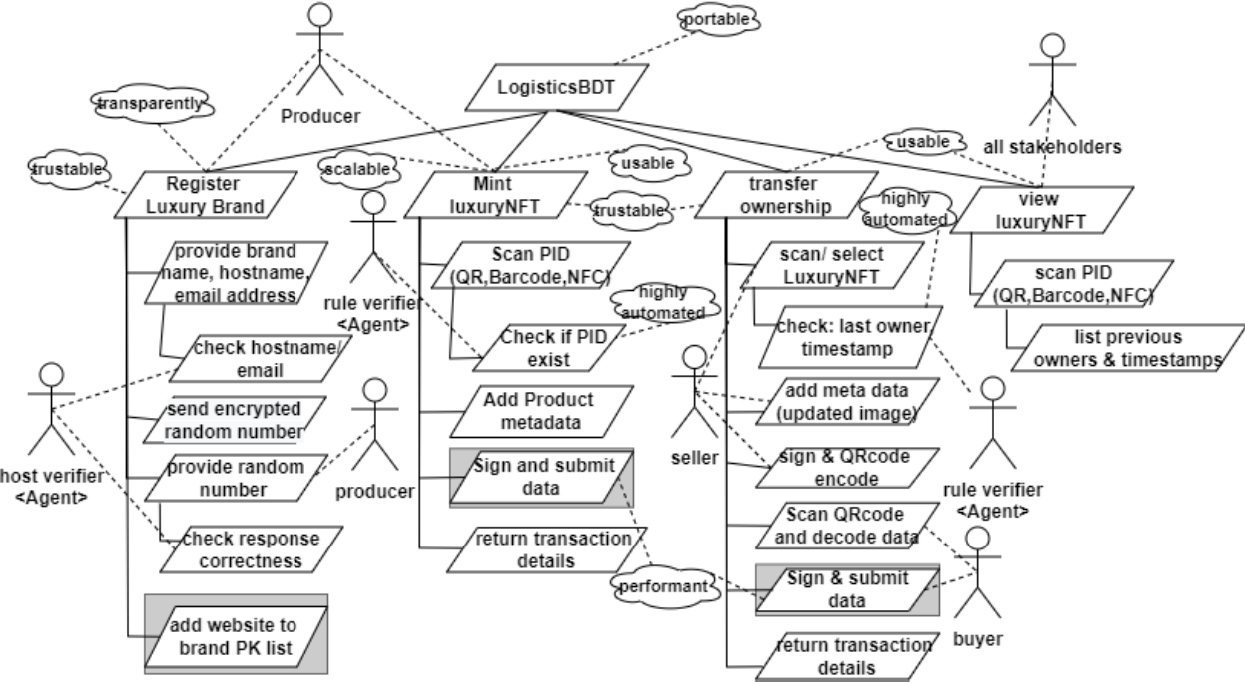
Figure 3. Requirement model of LogisticsBDT.